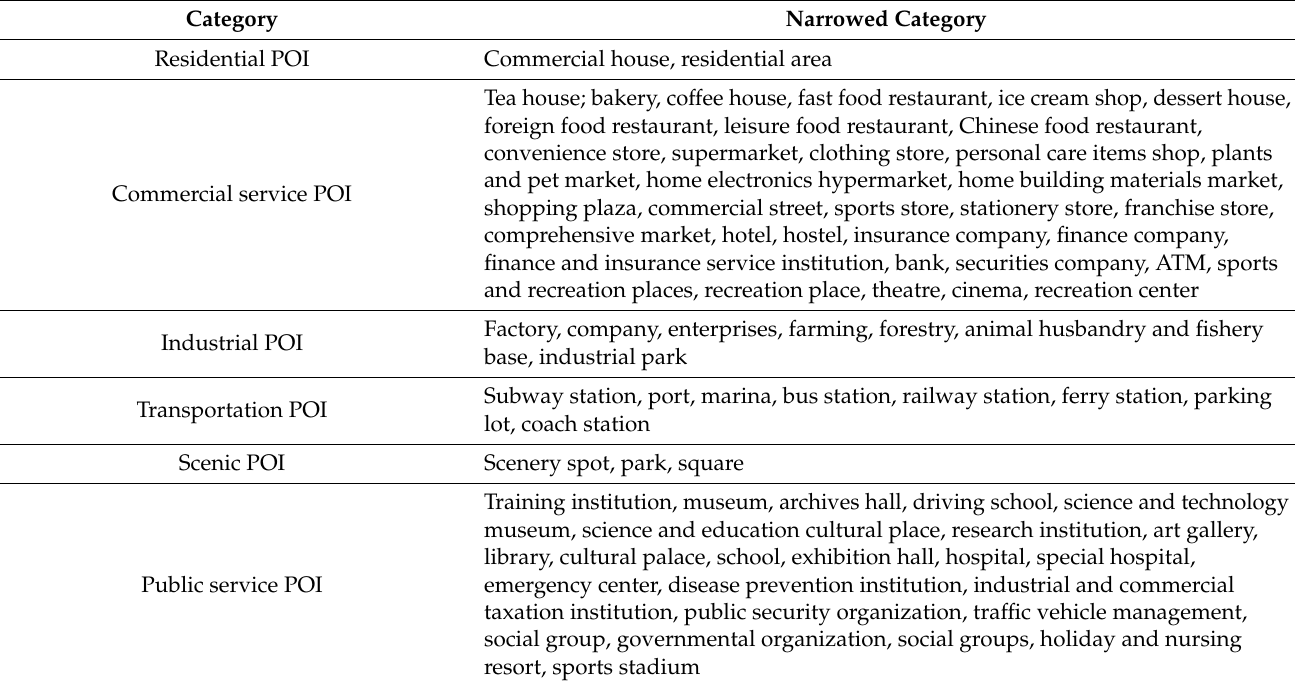
Table 1. Reclassification results of points-of-interest (POI) data.